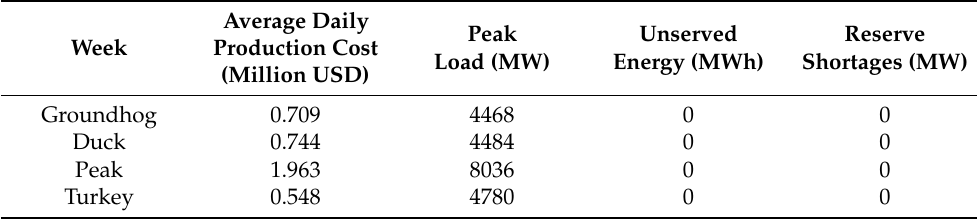
Table 6. Summary of production costs and reliability metrics for the RTS-GMLC base case with no